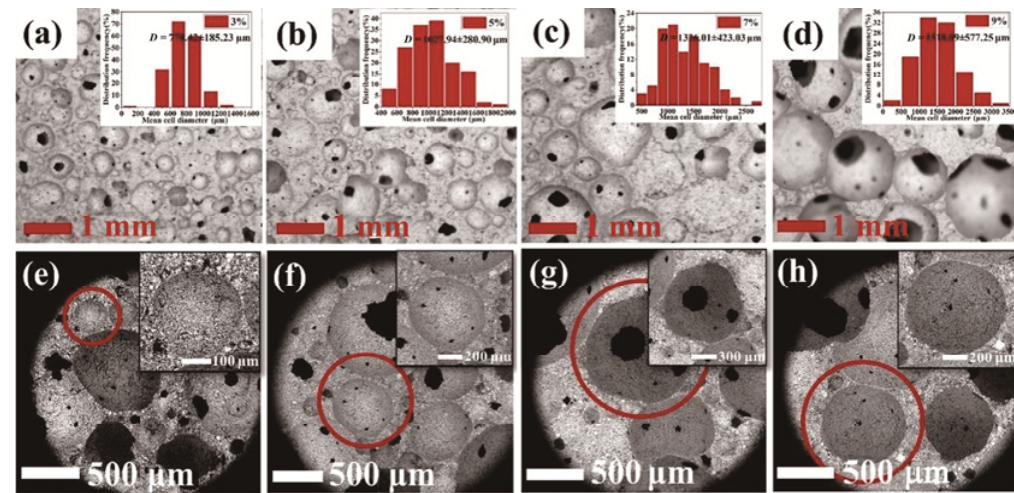
Fig. 3 Optical and SEM images and average cell size distributions of samples with H 2 O 2 concentrations of (a, e) 3%, (b, f) 5%, (c, g) 7%, and (d, h) 9%.